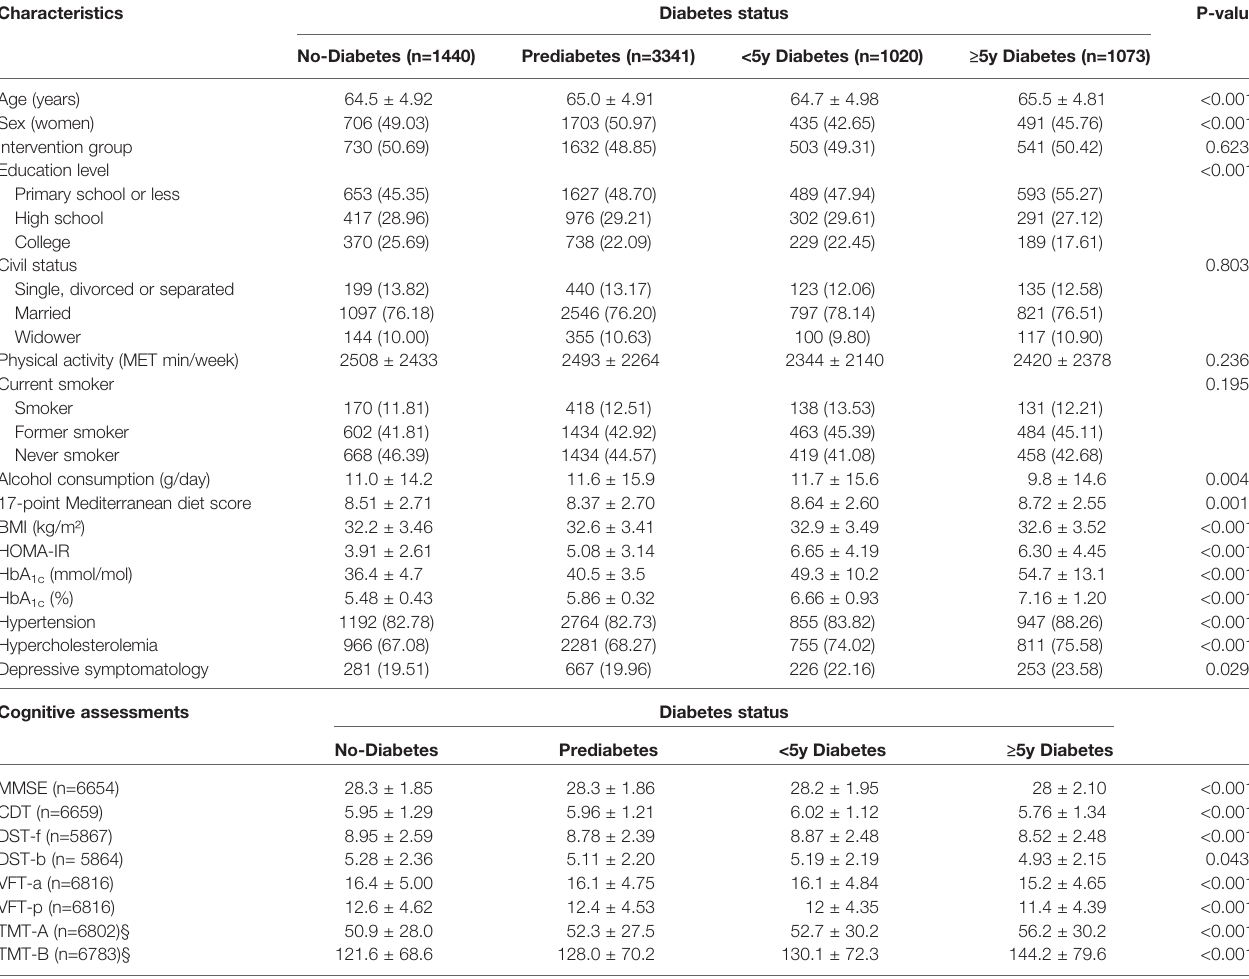
TABLE 1 | Baseline characteristics by diabetes status.